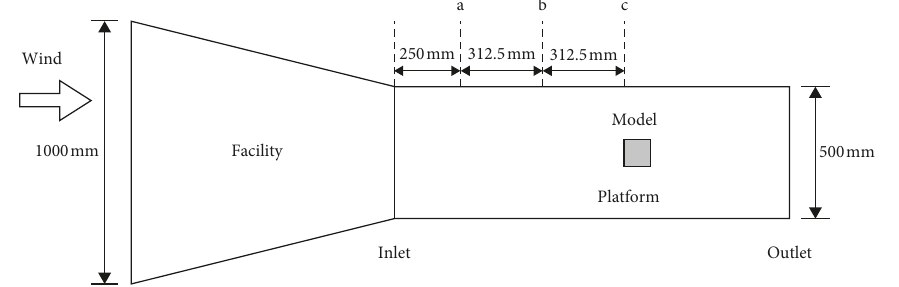
Figure 2: Diagram of the wind tunnel